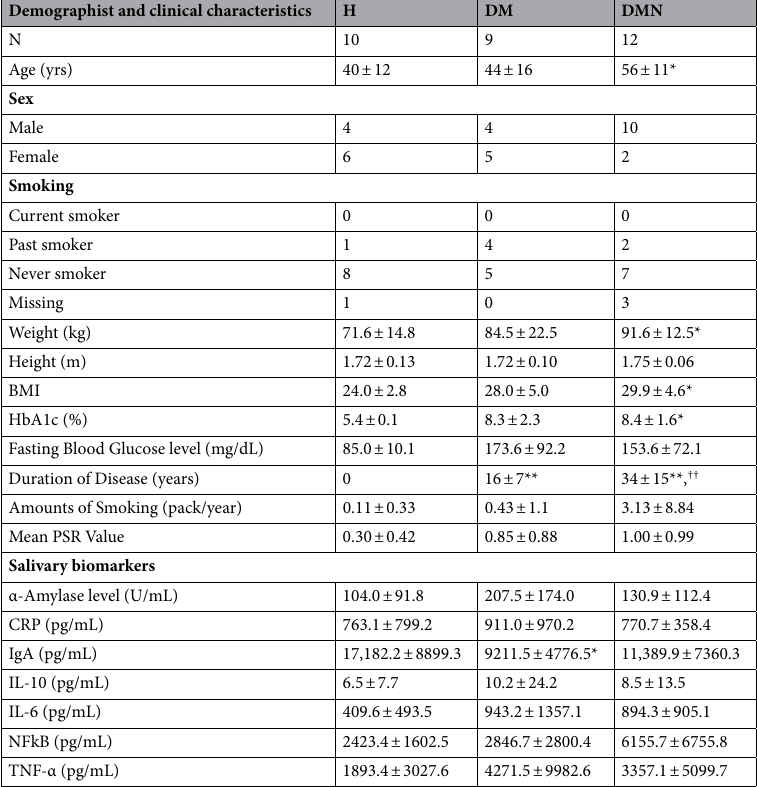
H vs DM H vs DMN DM vs